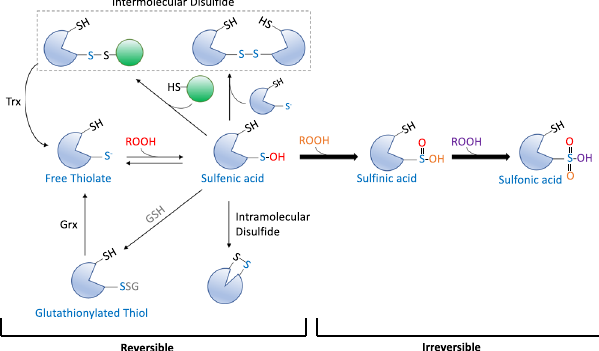
Figure 1. In the presence of an oxidizing agent (ROOH), the thiolate anion of a redox-sensitive Cys (Cys-S − ) is reversibly oxidized to form a sulfenic acid (SOH). When in close proximity to another reactive Cys (SH), either in the same protein molecule or in another protein, SOH leads to disulfide bond (S-S) formation. In addition to Cys residues in proteins, SOH can also react with the cellular antioxidant, glutathione (g-Glu-Cys-Gly; GSH) to form a mixed S-S bond (PSSG). Aside from altering the chemical properties of the Cys residue and the tertiary structure of the protein, S-S bonds are also believed to prevent terminal oxidation to sulfinic (SO 2 H) and sulfonic